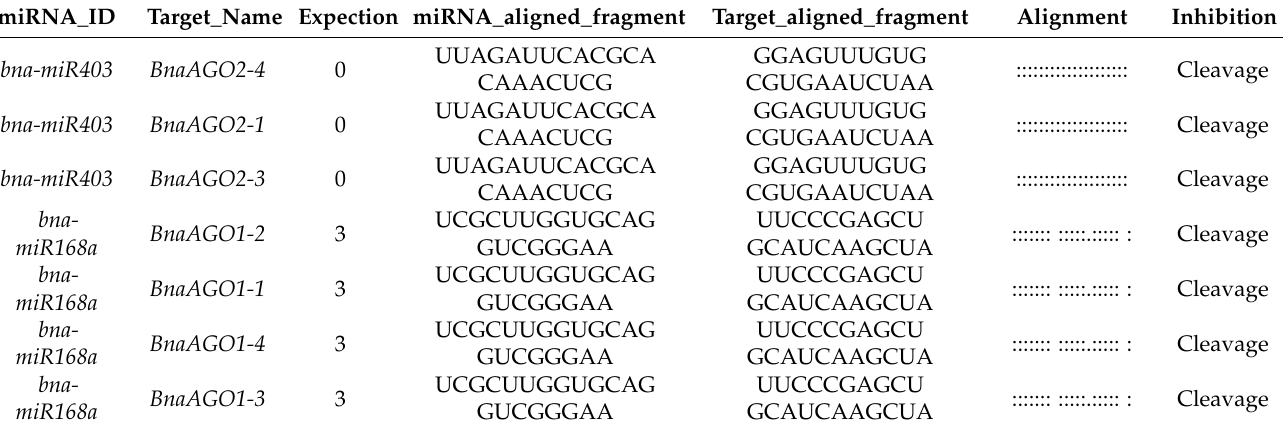
Table 3. The complementarities between B. napus miRNAs and the 7 BnaAGOs